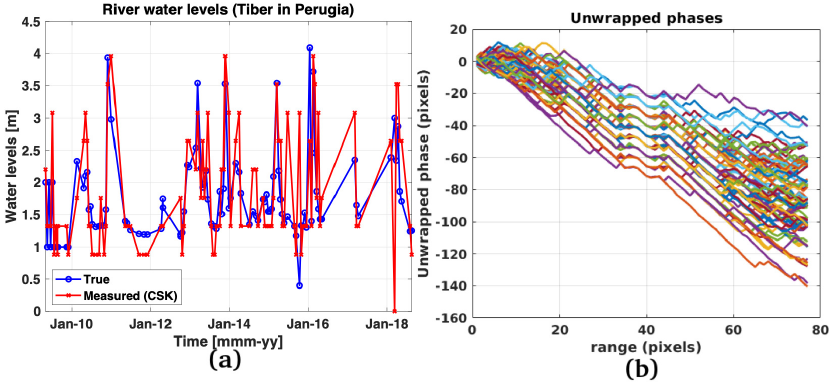
Figure 13. Case study 2 experimental measurements. ( a ): Water levels observed by the ground measurement station (blue line) and by the satellite (red line). ( b ): Unwrapped phases.